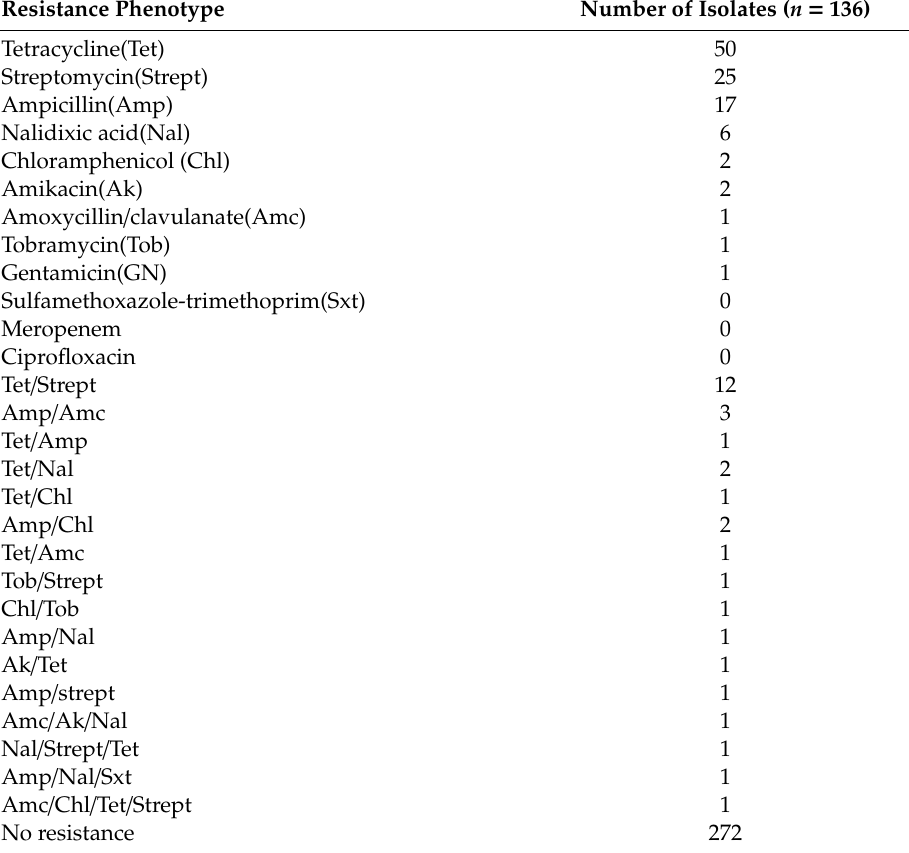
Table 1. Number and percentages of antibiotic resistance phenotypes in 136 resistant E. coli isolates from pastured meat goats.